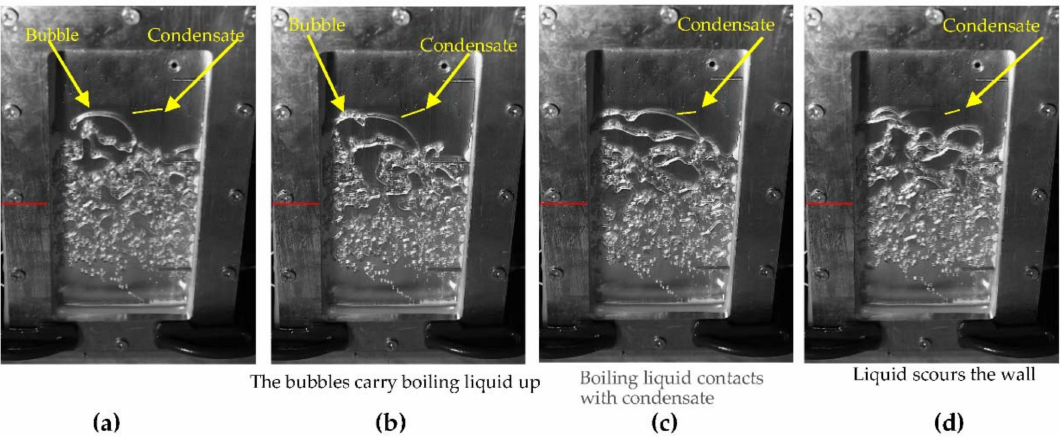
Figure 22. Typical images of gas-liquid two-phase hydrodynamic behavior in the cavity of PGHP (FR = 48%, Q in = 140 W, ∆ t = 35 ms). Note: the initial level is shown as the red line, ( a ) hydrodynamic behavior at 0 ms; ( b ) 35 ms; ( c ) 70 ms; ( d ) 105